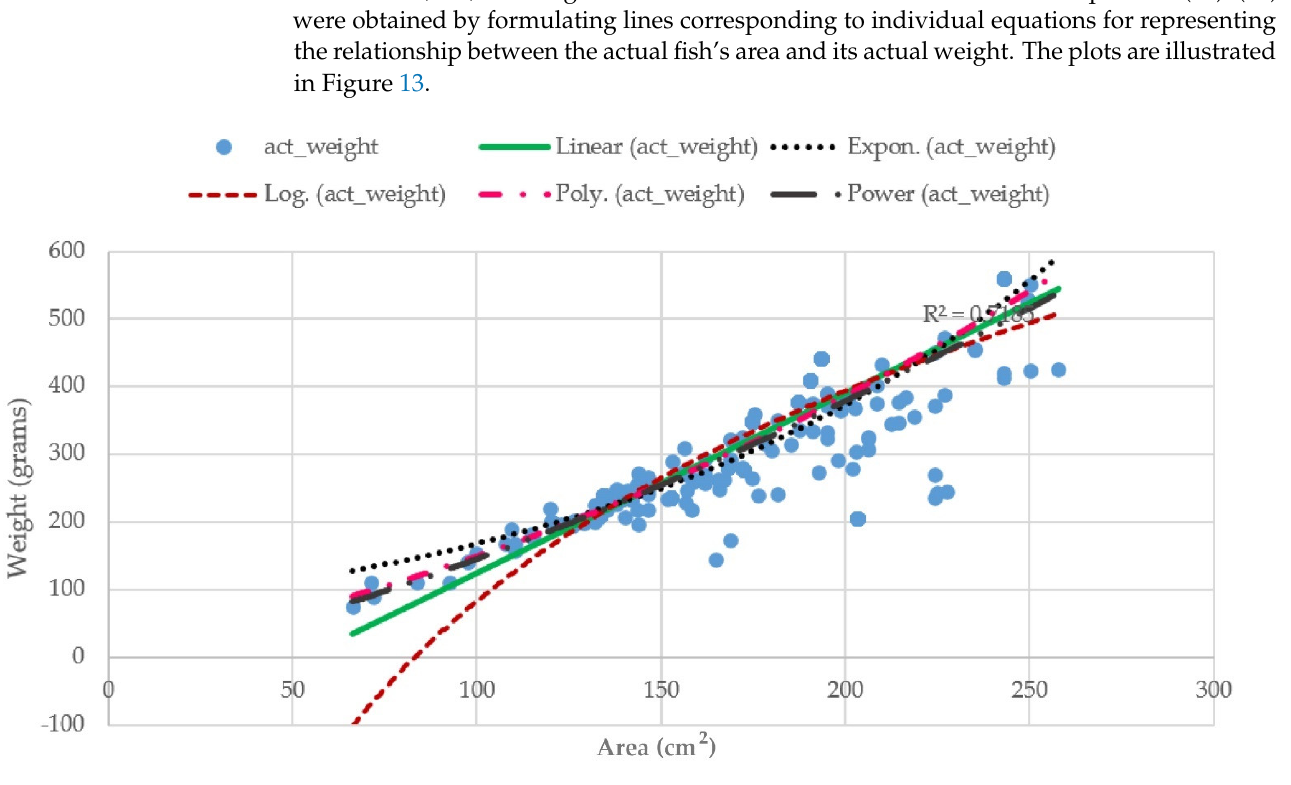
Figure 13. Cartesian coordinates of a point of the Euclidean plane for determining the coefficients of Equations (14)–(18).